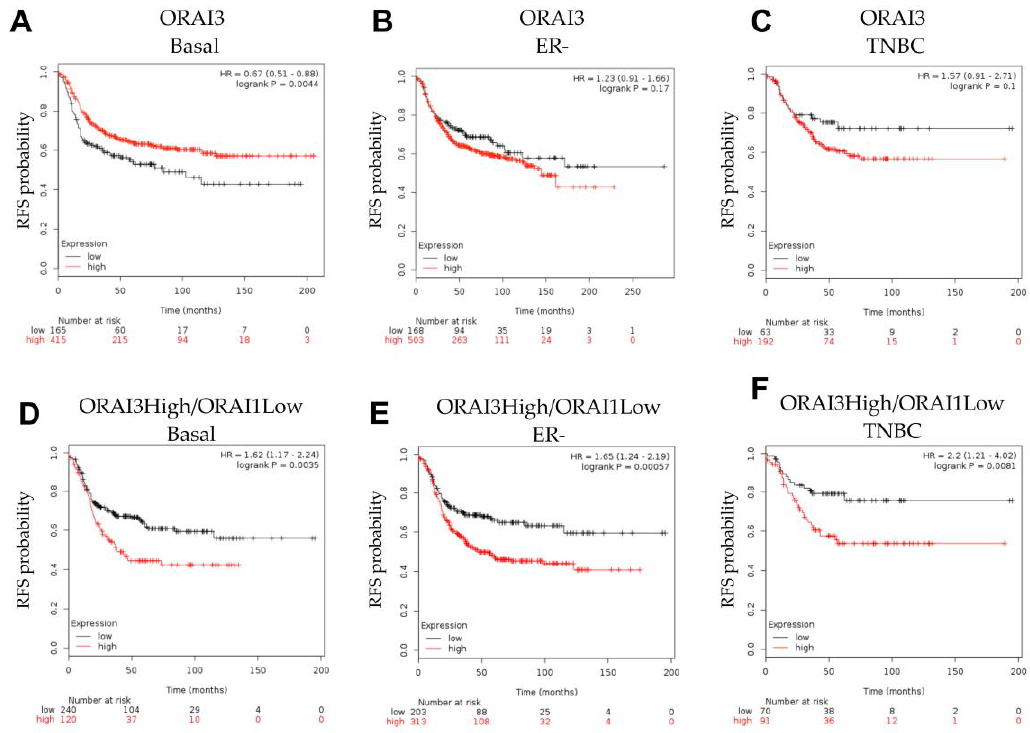
Figure 7. Expression of ORAI3 in combination with ORAI1 stratifies the survival of Basal, ER- and TNBC. Stratification of patient relapse free survival (RFS) in basal, estrogen-receptor negative (ER-) and triple negative breast cancer (TNBC) from the KM Plotter cohorts. Stratification of patient survival was based on ORAI3 expression in ( A – C ), and on ORAI3 in combination with ORAI1 expression in ( D – F ), where ‘high’ group (red) is high expression of ORAI3 and low expression of ORAI1 and the ‘low’ group (black) is low expression of ORAI3 and high expression of ORAI1 .